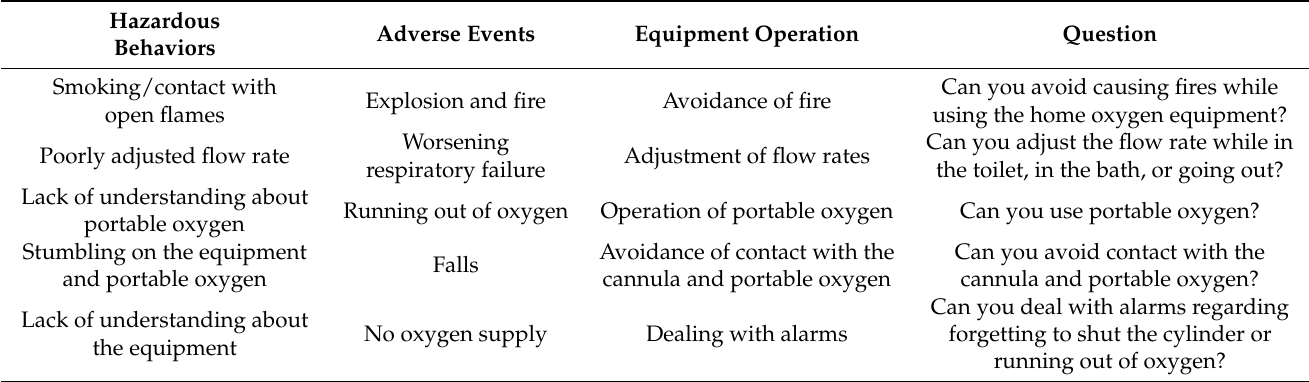
Table 1. Hazardous behaviors and adverse events related to the ability to operate long-term oxygen therapy equipment and questions to measure them.